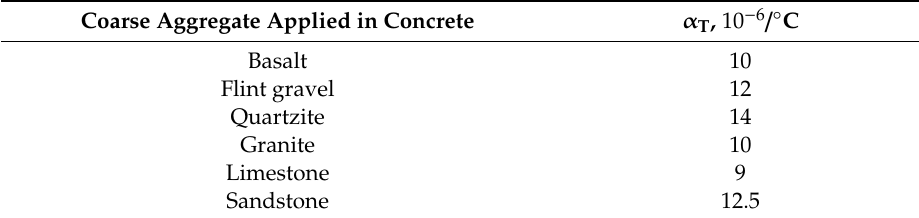
Table 7. The coe ffi cient of thermal expansion of concrete [1].